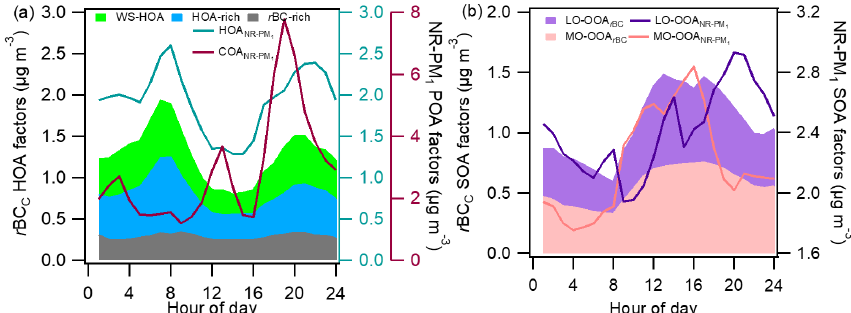
Figure 6. Comparisons of the diurnal patterns of different POA factors (a) and SOA factors (b) of rBCc particles and NR-PM 1 .